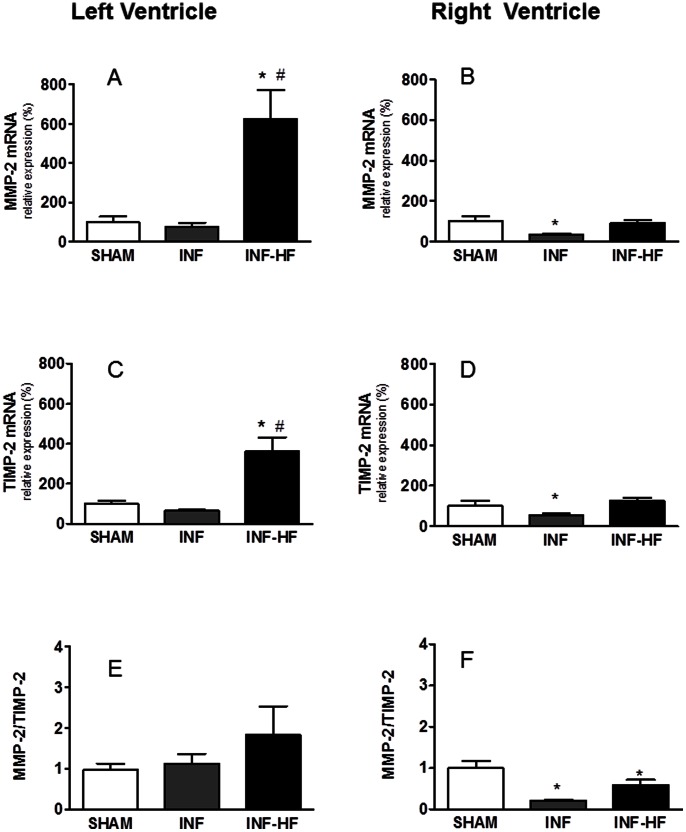
Metalloproteinase-2 (MMP-2, A and B), tissue inhibitor metalloproteinase-2 (TIMP-2, C and D) mRNA levels and MMP-2/TIMP-2 mRNA ratio (E and F) in left (A, C and E) and right ventricle (B, D and F) of sham-operated rats (SHAM) and infarcted animals with (INF-HF) or without heart failure (INF) 30 days after ligation of left coronary artery.Results were normalized by 18S expression levels. Data are mean ± S.E.M. *p<0.05 vs. SHAM group; # p<0.05 vs INF group.